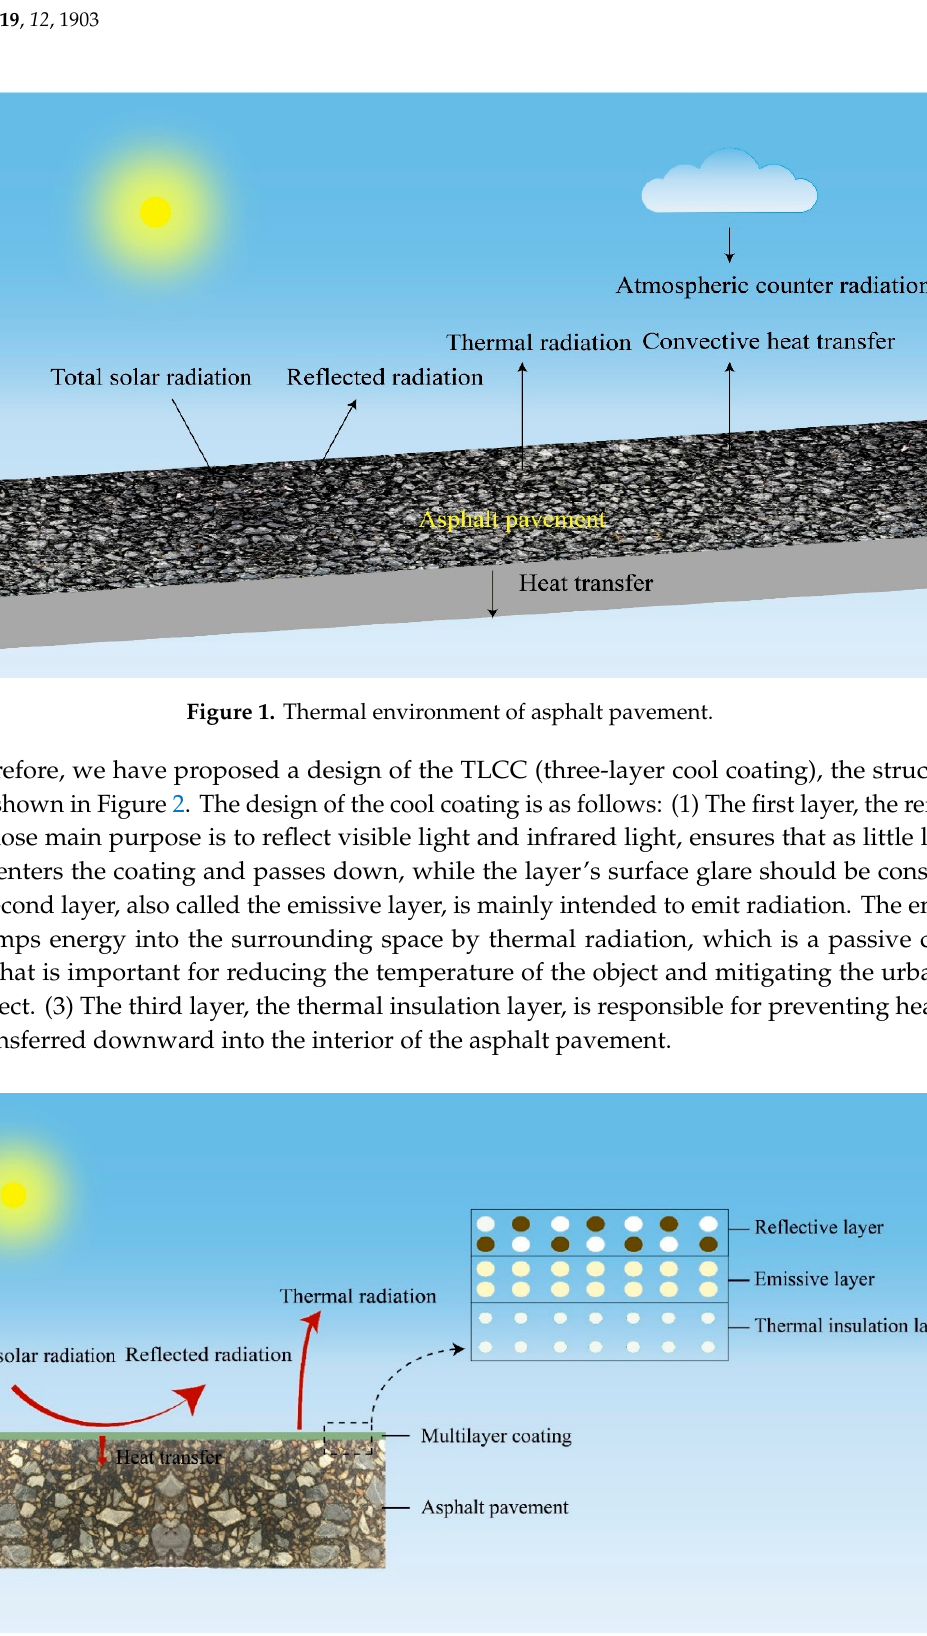
Figure 2. Working principle of the three-layer cool coating (TLCC).